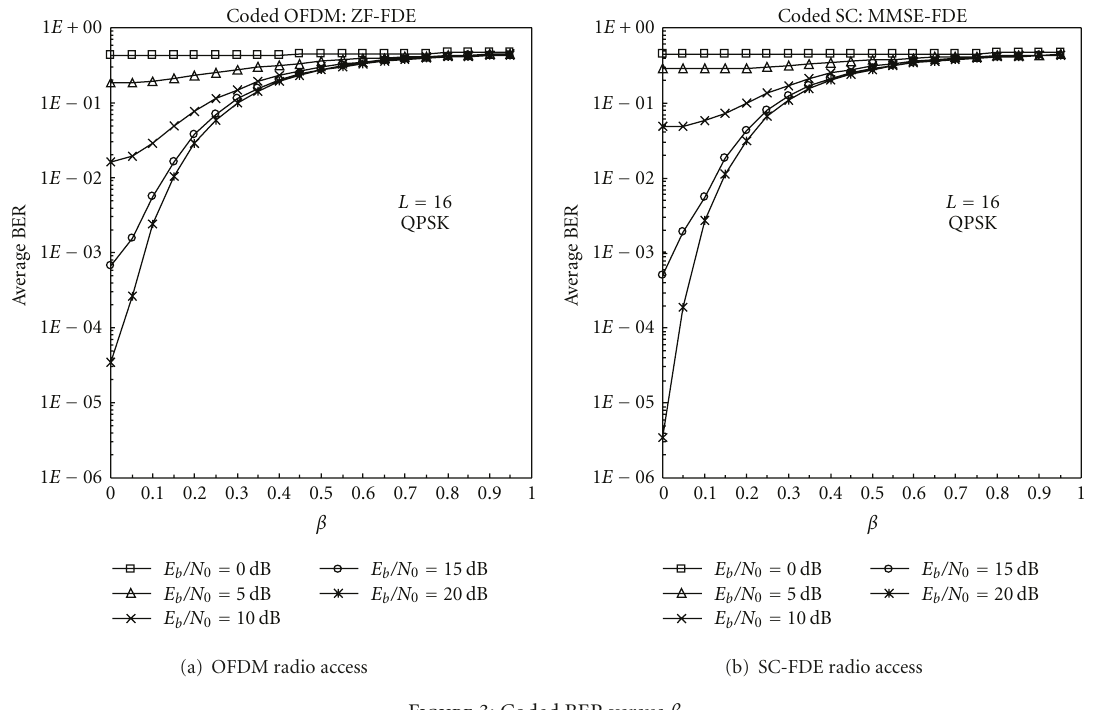
Figure 3: Coded BER versus β .